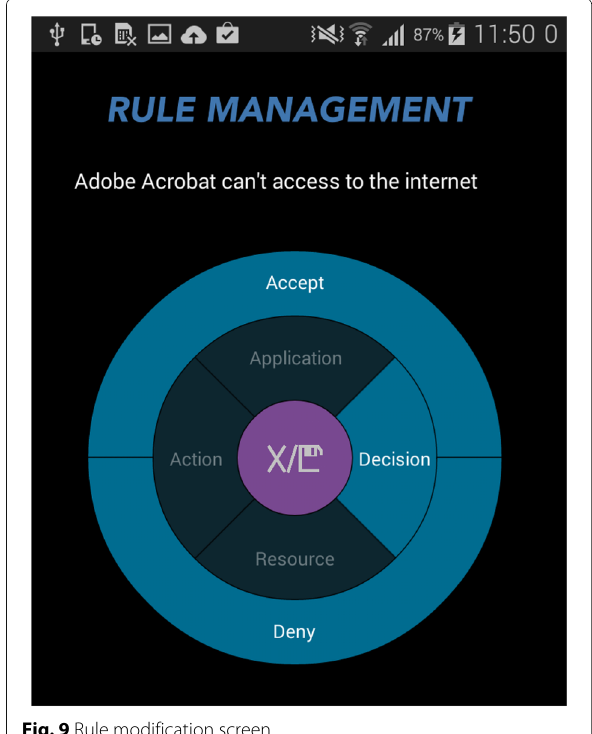
Fig. 9 Rule modification screen